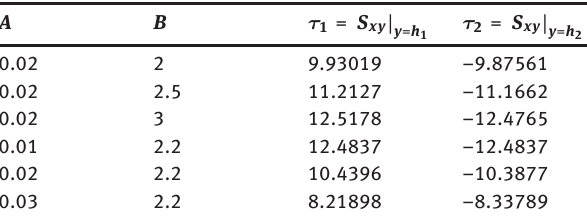
Table 1: Value of shear stress at walls h 1 and h 2 by fixing values